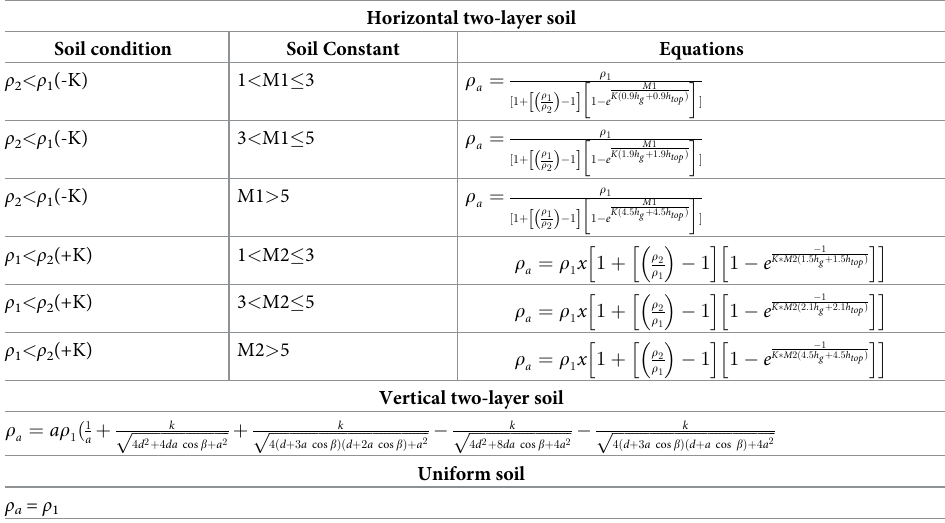
Table 3. Empirical formulas for apparent resistivity in different soil conditions [28].